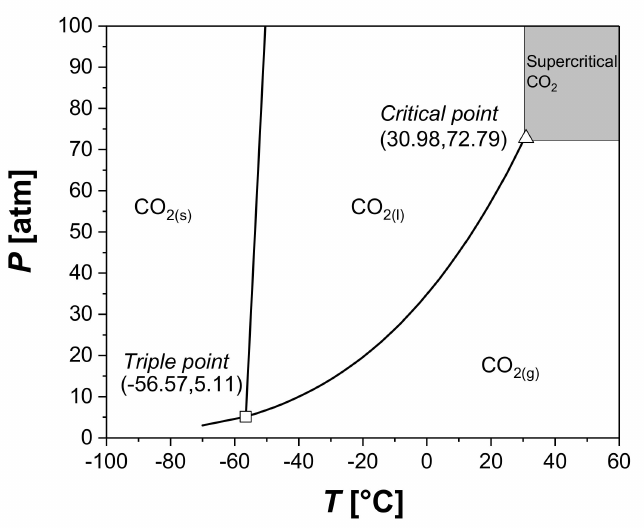
Figure 8. CO 2 phase diagram, highlighting the region of supercritical fluids and both the triple and critical